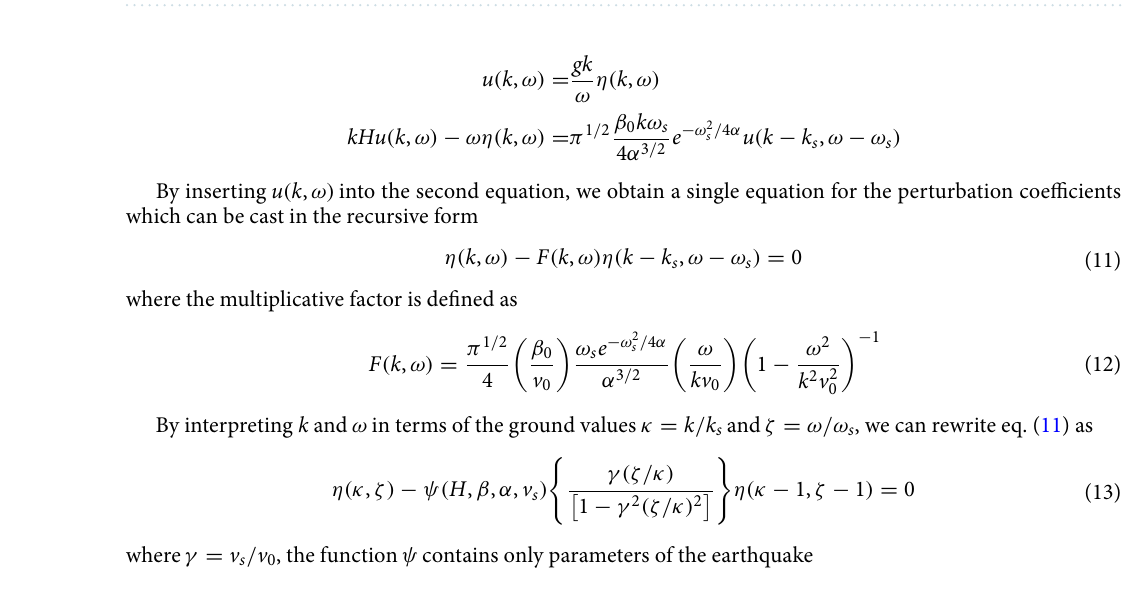
Figure 6. The figure shows, as an example, the comparison between observed (black circle) and modelled (red line) fluctuations of the vertical temperature profile for KOBE EQ (Top panel); In the bottom panel are shown the residuals with respect the model in 1 σ units. As can be seen the model follows very well the data profile as a function of the altitude with a good statistical